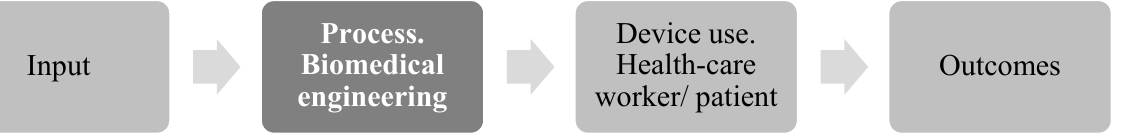
Process. Device use. Biomedical Health-care Input engineering worker/ patient Figure 1. Medical devices process from policies to health outcomes. Adaptation from [11] (p. 20).